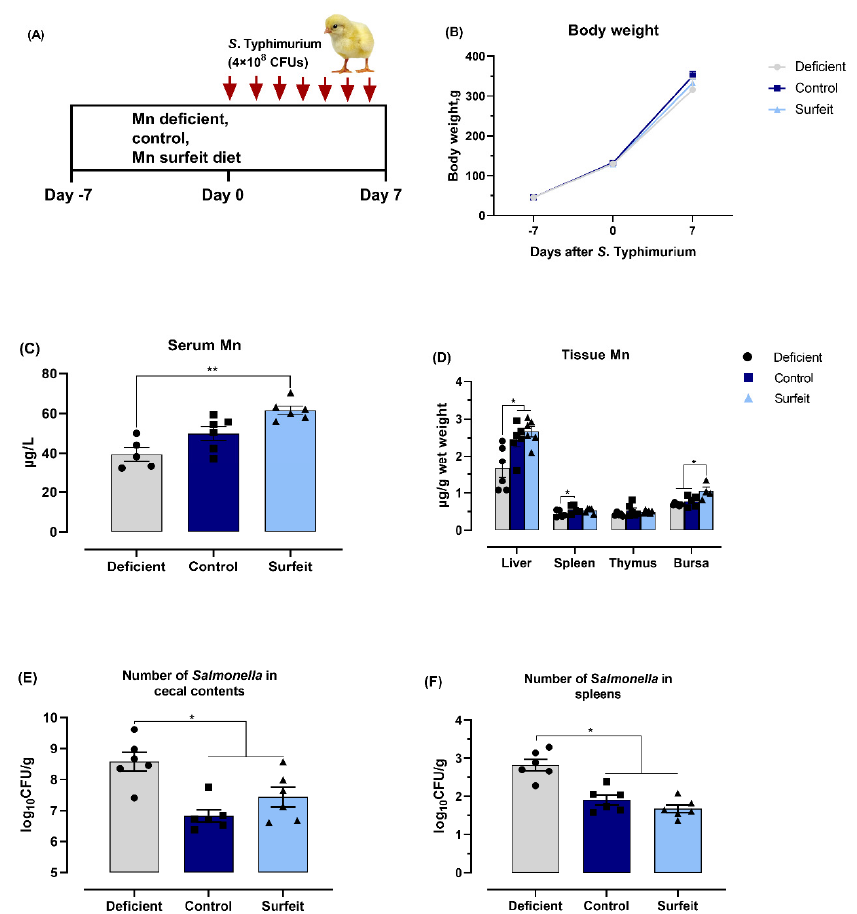
Figure 3 . Dietary Mn supplementation increases tissue Mn levels and decreases the number